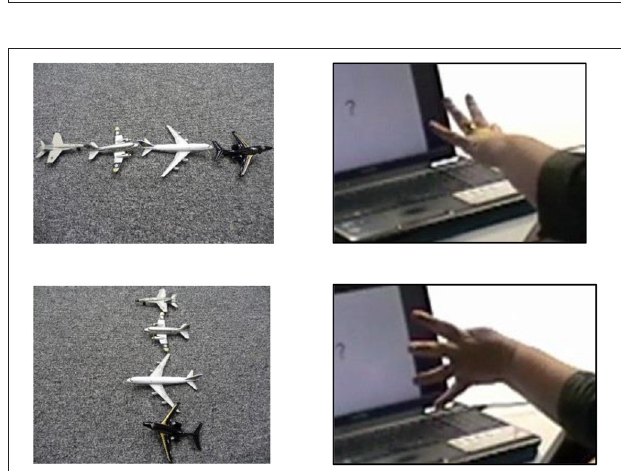
FIGURE 11 | This participant is describing a row of four planes with the four handshape.